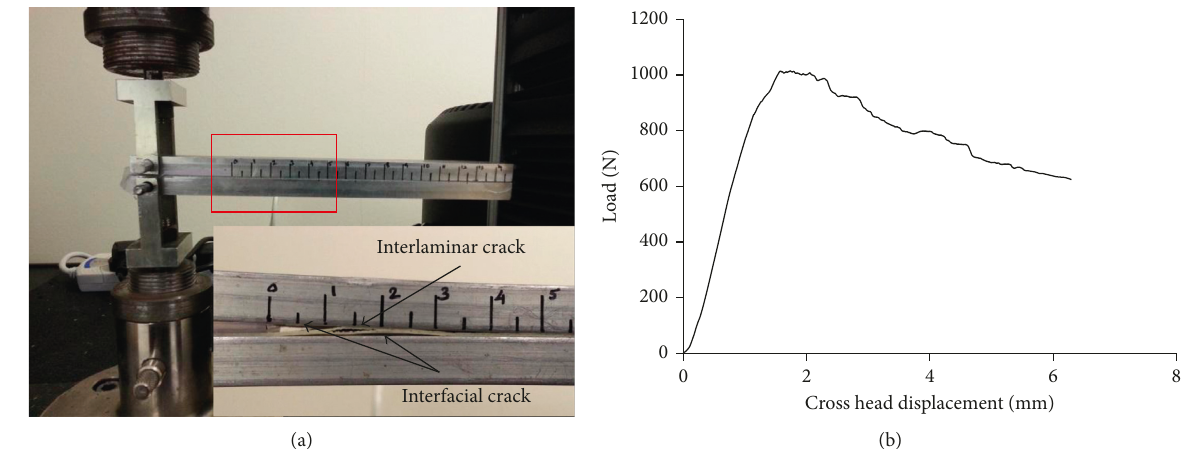
Figure 4: M-C-M DCB configuration: (a) multiple interface crack surfaces and (b) typical load-displacement